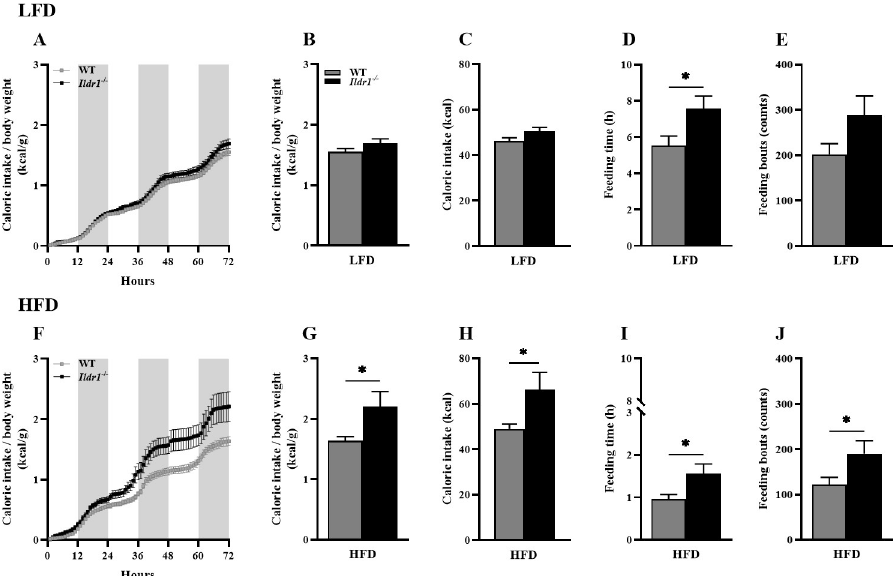
Fig 2. Feeding behavior of wild-type (WT) (grey line or bar) and Ildr1 -/- (black line or bar) mice given low fat (LFD, top row ) or high fat diets (HFD, bottom row ). (A) Ratio of caloric intake to body weight over 72 hr in mice fed the LFD. Light and dark cycles are represented as white or grey bars respectively over 24 hr intervals. (B) The results in panel A are expressed as the cumulative ratio for mice fed the LFD. (C) Caloric intake in mice given the LFD without normalization for body weight. (D) Cumulative time spent consuming the LFD diet [t(22) = 2.353, P = 0.028]. (E) Cumulative numbers of feeding bouts in LFD fed mice. (F) Ratio of caloric intake to body weight over 72 hr in the genotypes fed the HFD. (G) The results in panel F expressed as the cumulative ratio for mice fed the HFD [t(22) = 2.238, P = 0.036]. (H) Caloric intake in mice given the HFD without normalization for body weight [t(22) = 2.180, P = 0.040]. (I) Cumulative time spent consuming the HFD diet [t(22) = 2.417, P = 0.024]. (J) Cumulative numbers of feeding bouts in HFD groups [t(22) = 2.097, P = 0.048]. n = 12 mice/genotype/diet; � P < 0.05, WT vs . Ildr1 -/- .